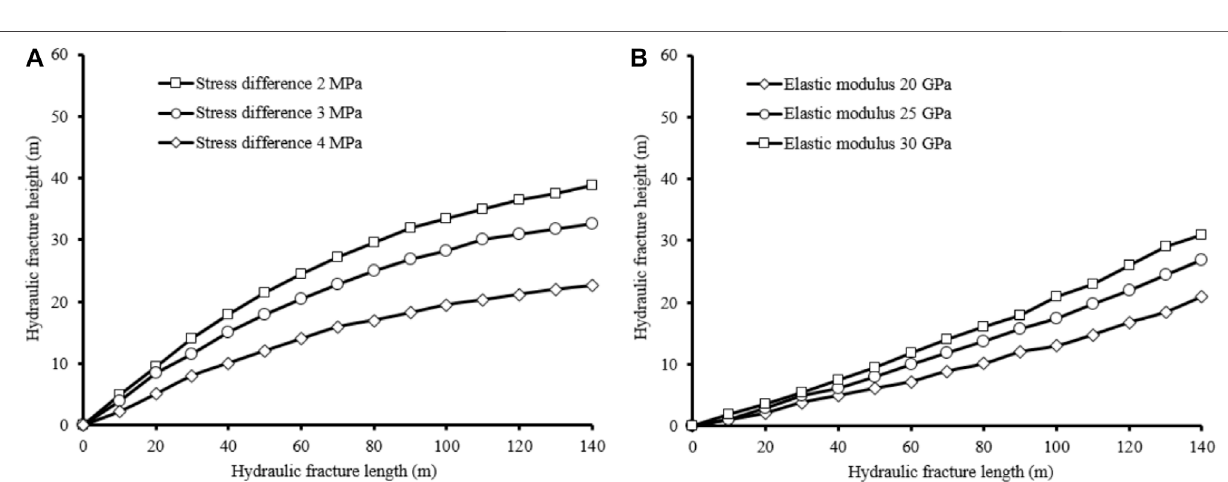
Frontiers in Earth Science |